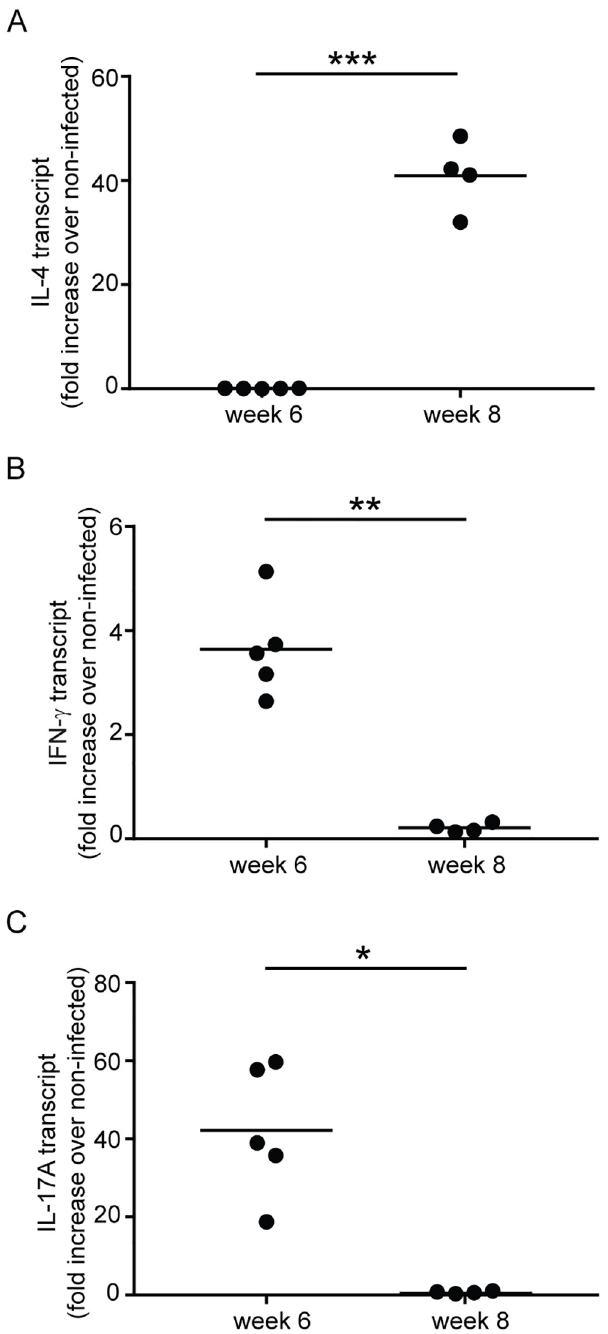
Fig 7. The abundance of IL-4, IFN- γ and IL-17A mRNA mirrors the relative frequency of T H 2, T H 1 and T H 17 cells at 6 and 8 weeks post infection with S . mansoni . The relative abundance of IL-4 (A), IFN- γ (B) and IL-17A (C) mRNA in spleen cells from S . mansoni -infected mice at 6 and 8 weeks post infection was determined by quantitative real-time PCR. Results are expressed as fold change in the experimental groups compared to equivalent cells from non- infected control mice. � , P < 0.05; �� , P < 0.01; ��� , P <